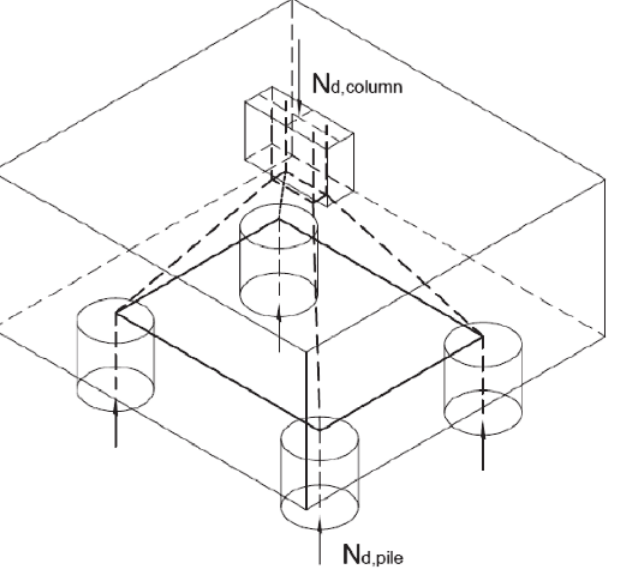
Figure 1 Three-dimensional truss model for four-pile cap